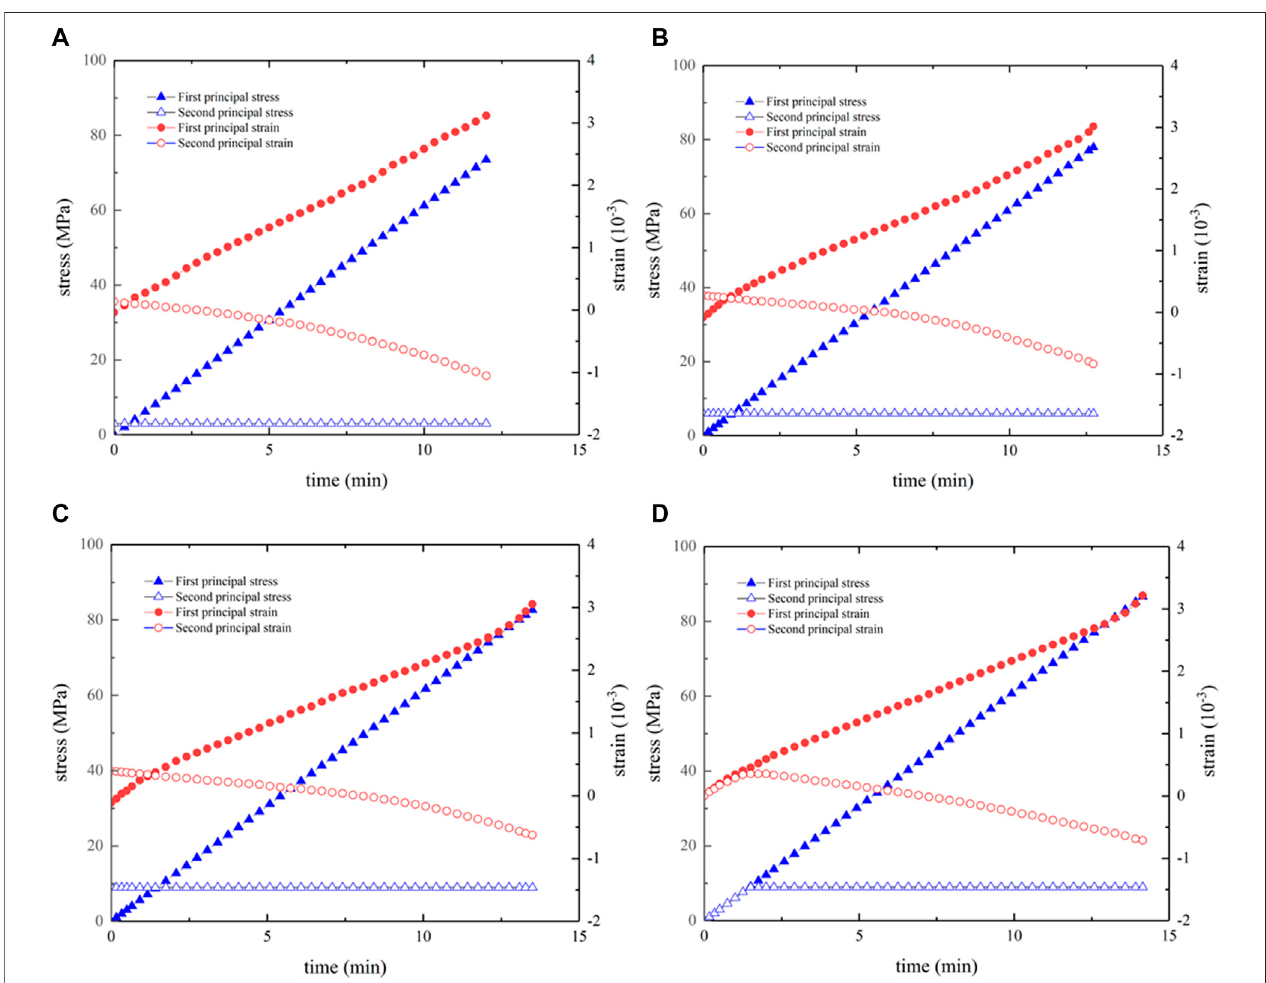
FIGURE 2 | Stress-strain-time curves for different loading paths under biaxial compression experiments.